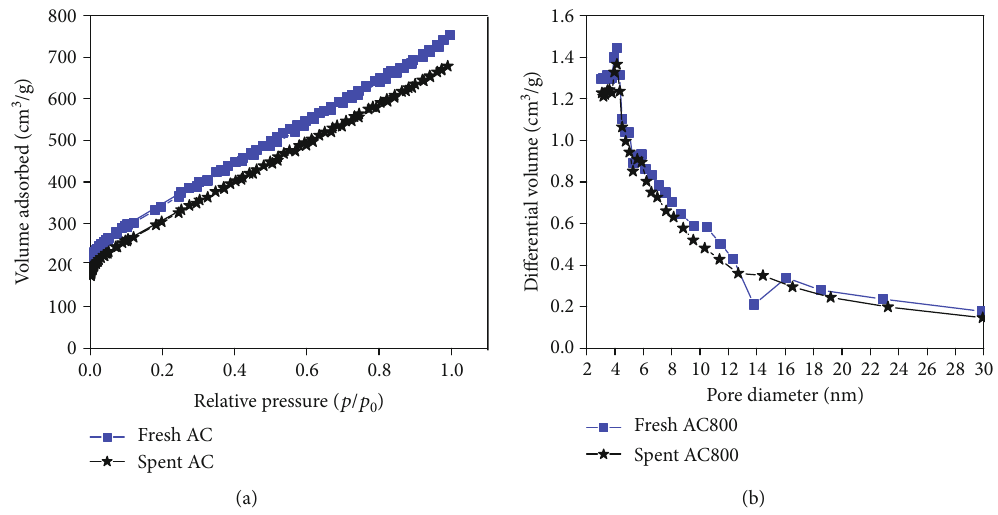
Figure 2: (a) Adsorption-desorption isotherms of the activated carbon. (b) Pore size distribution. Table 5: Summary of the results for non-activated and AC sweet potato leaves.